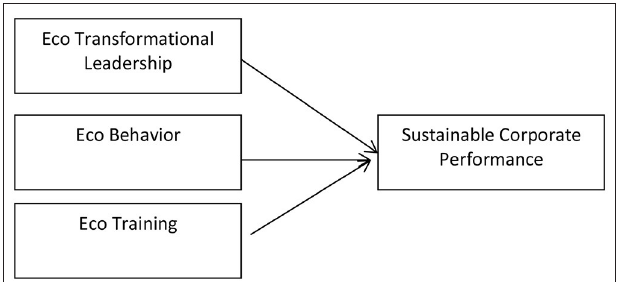
FIGURE 1 | H1: There is a Positive Effect of Eco Transformational Leadership on Sustainable Corporate Performance, H2. There is a Positive influence of Employee Eco Behavior on Sustainable Corporate Performance, and H3. There is a Positive Effect of Eco Training on Sustainable Corporate Performance. Source: Figure is statistic tools generated by